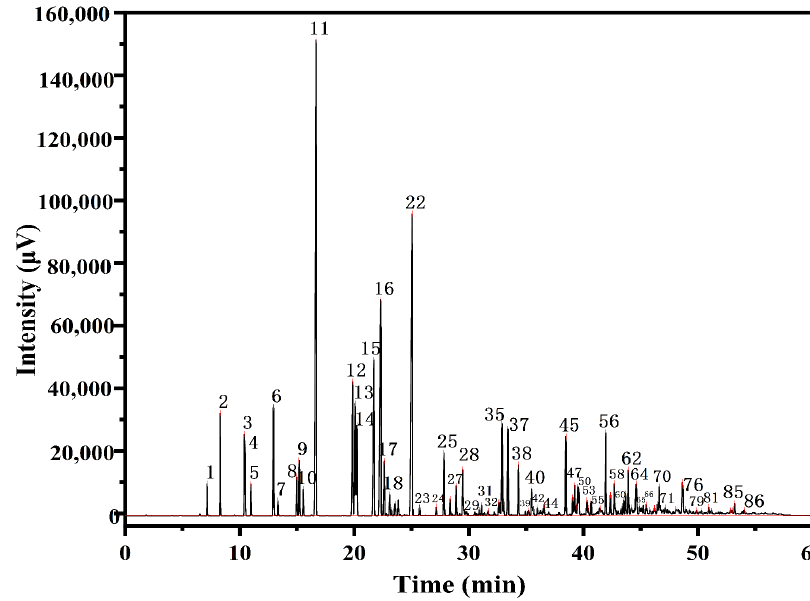
Figure 1. Gas chromatogram of the C 4 alkylation reaction products.